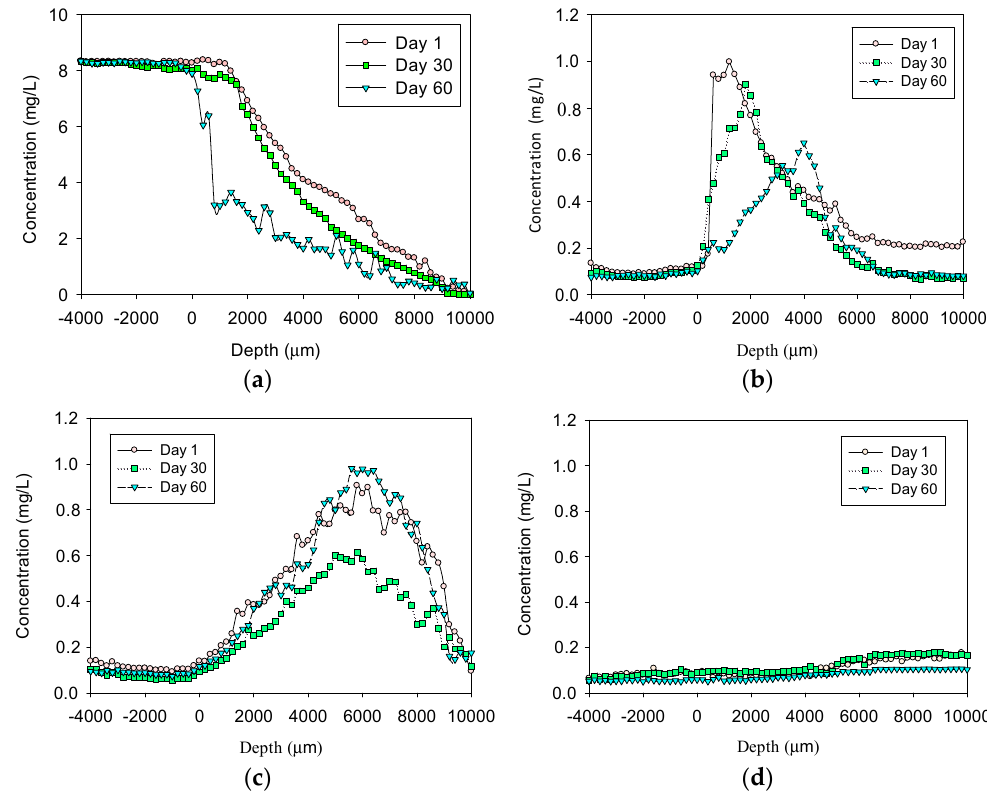
Figure 1. Microsensor profiles within the 10,000 μ m sediment layer: ( a ) dissolved oxygen (DO); ( b ) NH 4+ -N; ( c ) NO 3 − -N; and ( d ) NO 2 − -N.